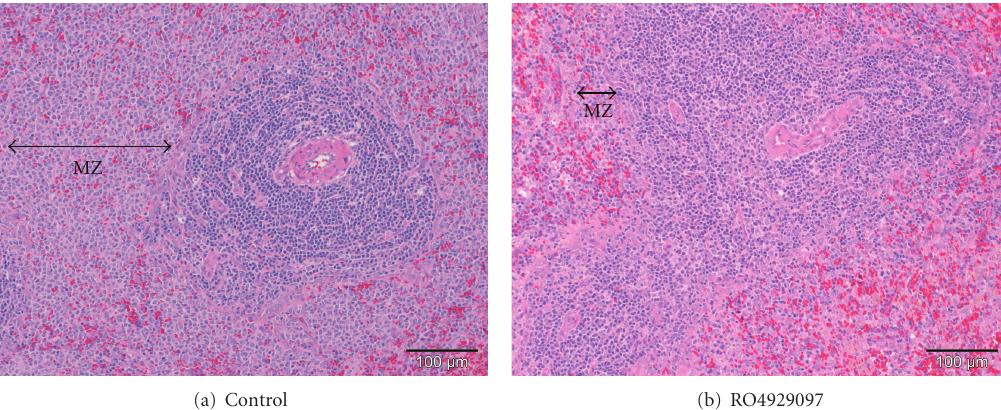
Figure 2: Atrophy of the marginal zone (MZ) of the spleen of rats administered 3.0 mg/kg/day RO4929097 for 13 weeks. (hematoxylin-eosin